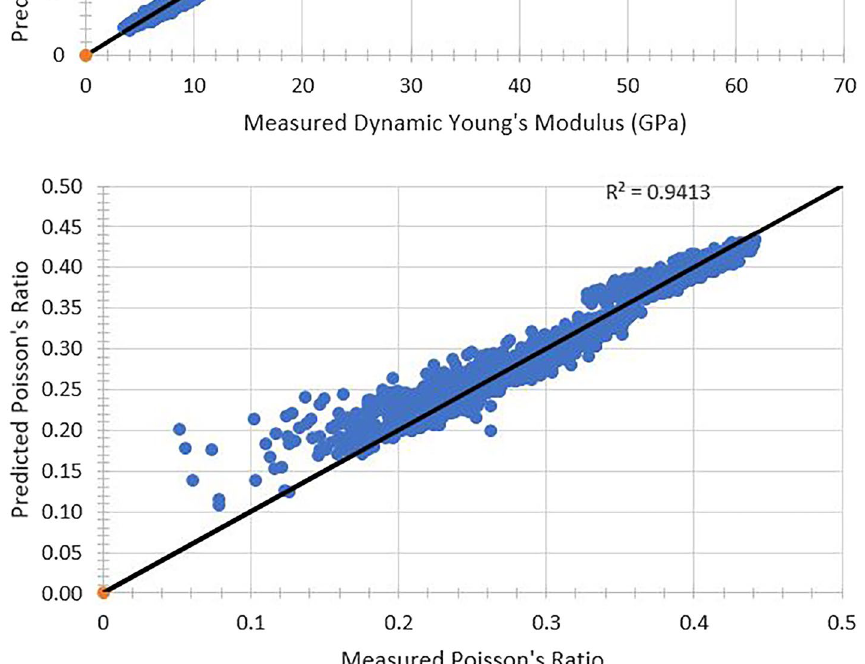
Fig. 11 Cross-validation plot of predicted and measured Pois- son’s ratio